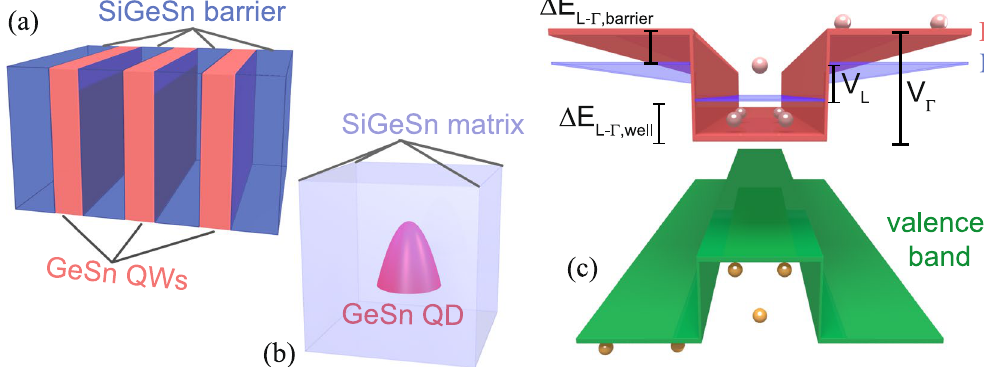
Figure 1. ( a ) Schematic layer structure of the 3 × {30 nm GeSn/40 nm SiGeSn} MQW and ( b ) a cone shaped GeSn QD embedded in a SiGeSn matrix as discussed in this work. ( c ) Type-I band alignment between well and barrier with the band discontinuities V Γ , L = E Γ , L , SiGeSn − E Γ , L , GeSn and well directness Δ E L- Γ